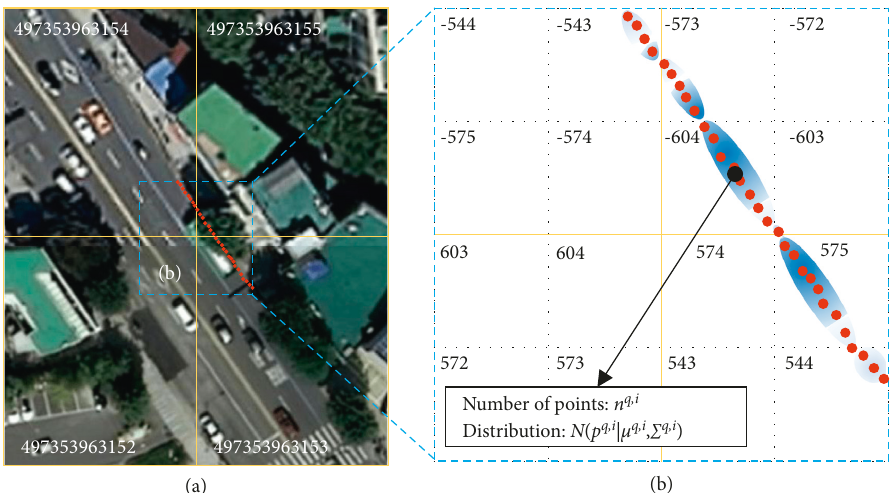
Figure 2: GND map structure in (a) geodetic tiles and (b) Cartesian voxels at the sea-level floor (1209